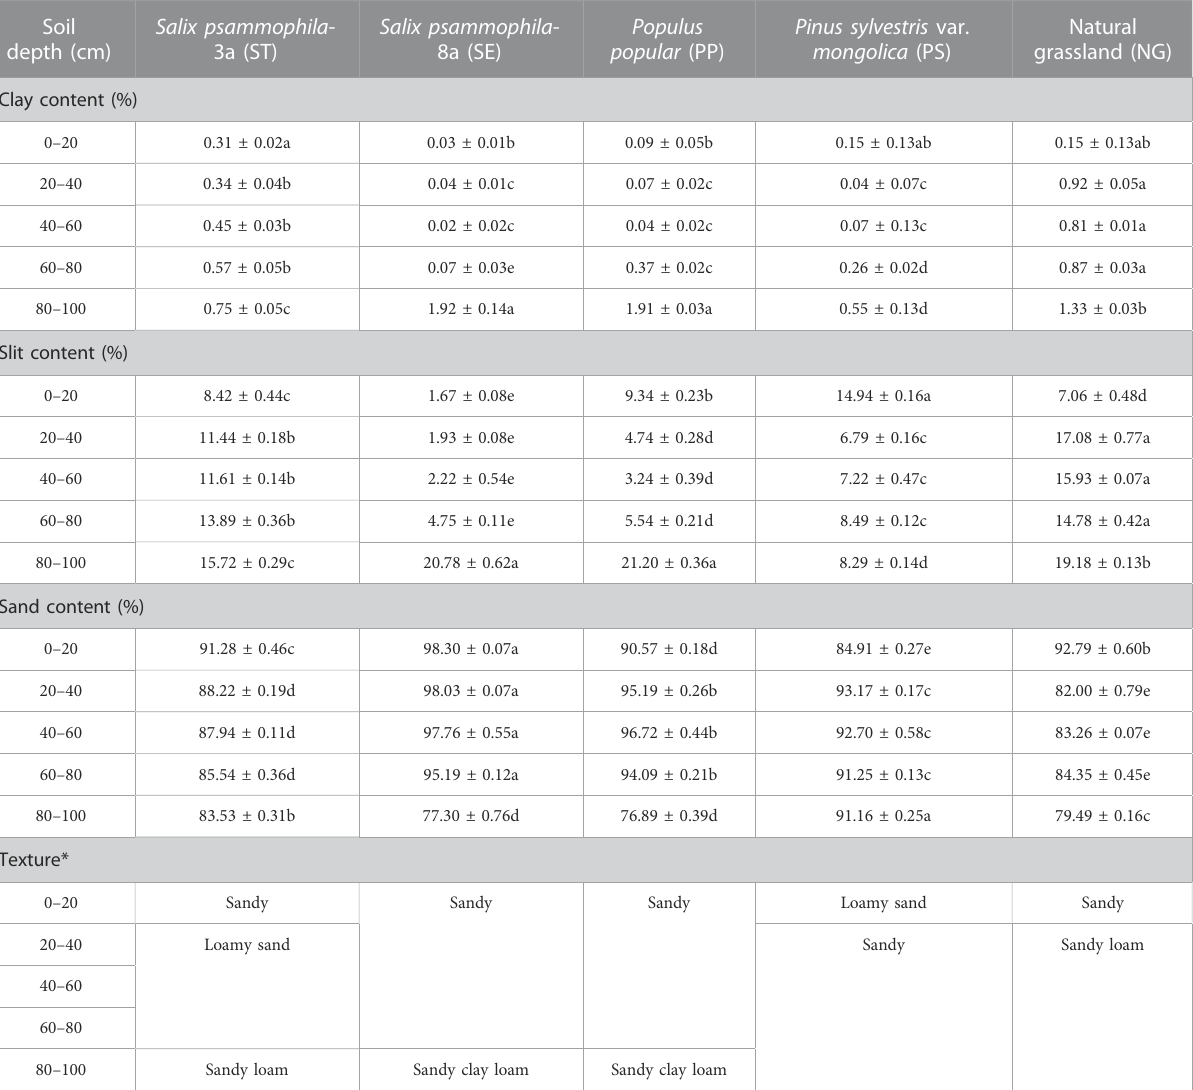
TABLE 2 Soil particle composition under different vegetation